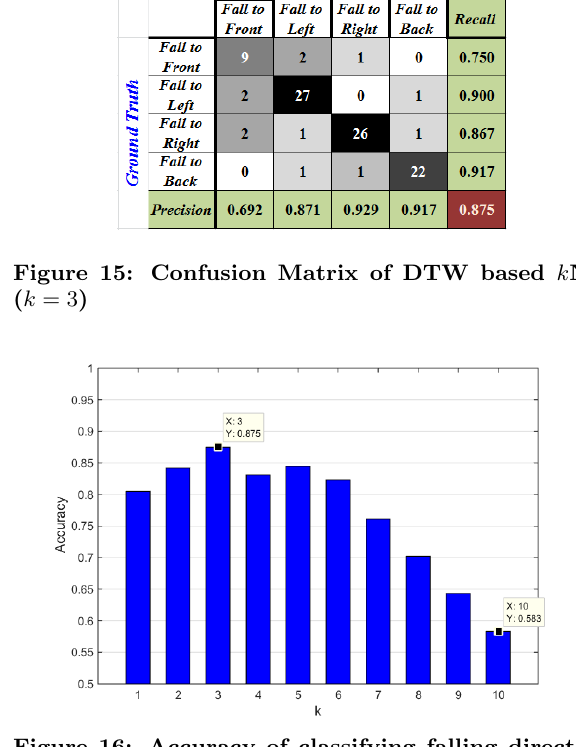
Figure 16: Accuracy of classifying falling direction varies with parameter